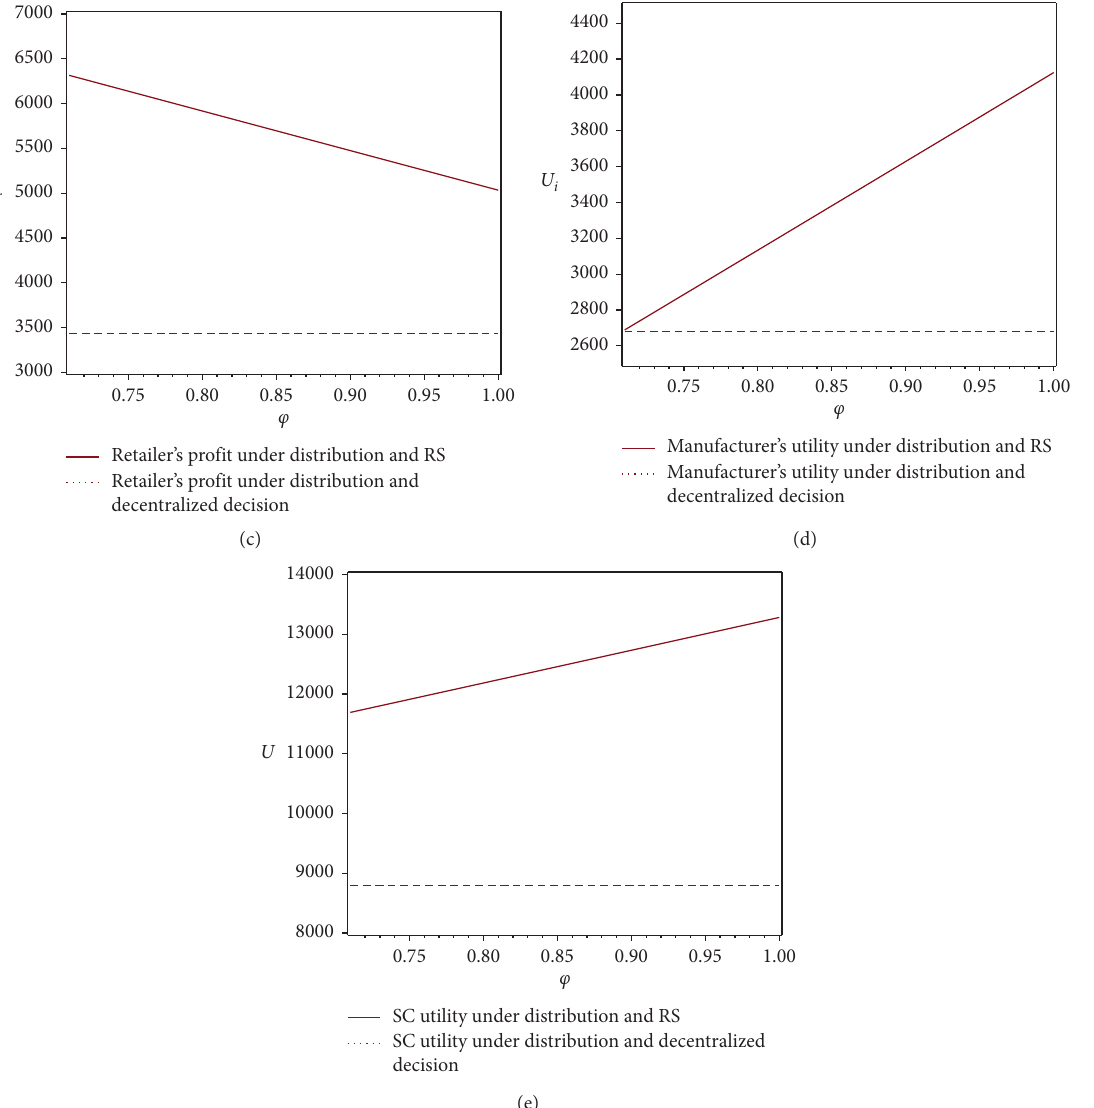
Figure 3: Impact of RS contracts on supply chains of manufacturer’s distributional fairness concerns: (a) the impact of RS on W-Price; (b) the impact of RS on R-Price; (c) the influence of RS on retailer profit; (d) the influence of RS on manufacturer profit; (e) the influence of RS on the total utility of supply